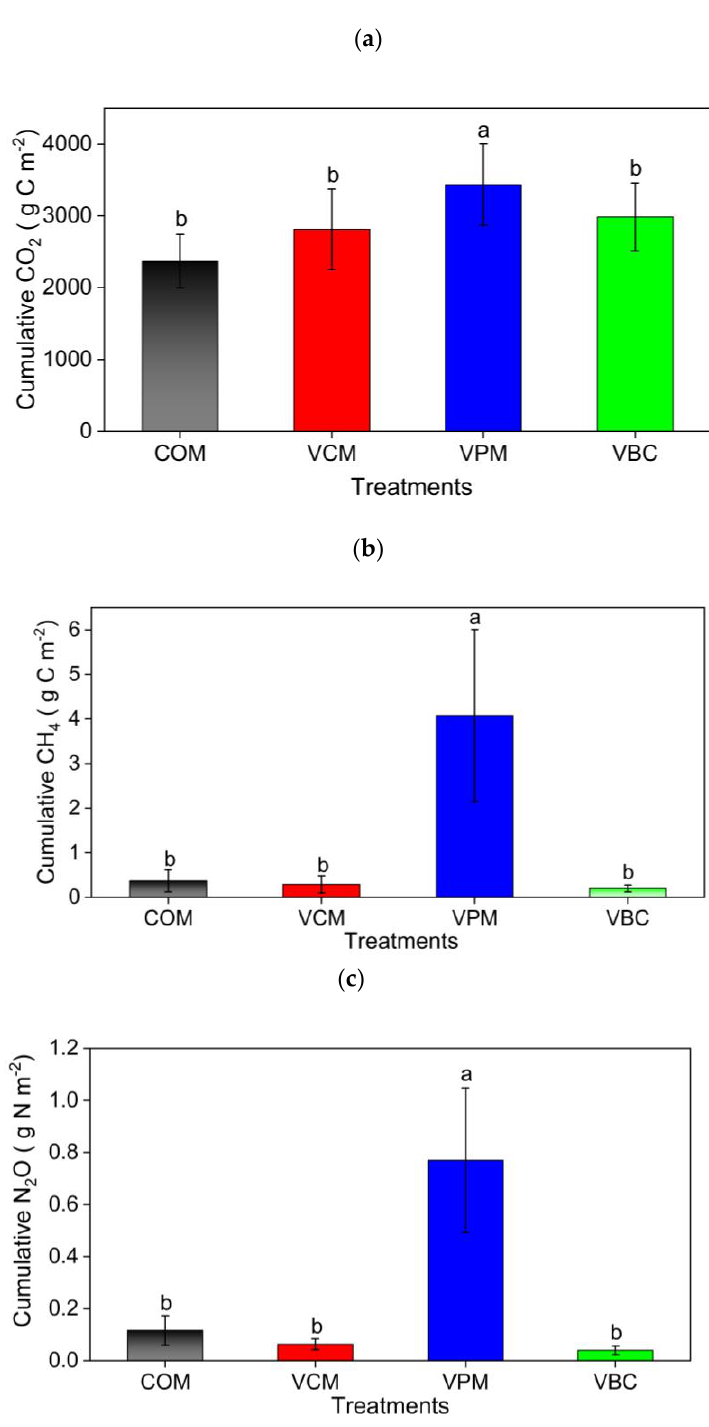
Figure 7. Cumulative carbon dioxide ( a ) methane ( b ), and nitrous oxide ( c ) in treatments for the whole experimental duration as an average of three replicates. Error bars represents standard errors. Different letter indicates significant differences among treatments ( p < 0.05).